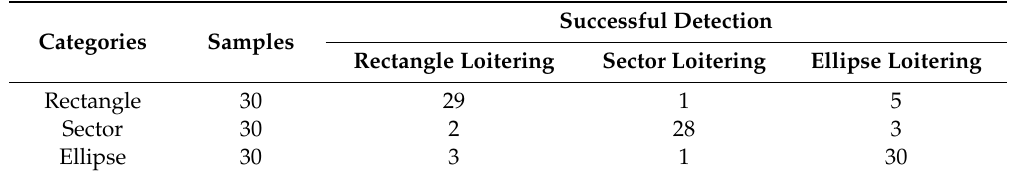
Figure 16. The different algorithms to test the same scenarios to distinguish the advantages and Figure 16. The di ff erent algorithms to test the same scenarios to distinguish the advantages and differences of the three algorithms. di ff erences of the three algorithms. Table 3. The results of the three-algorithm Table 3. The results of the three-algorithm comparison.